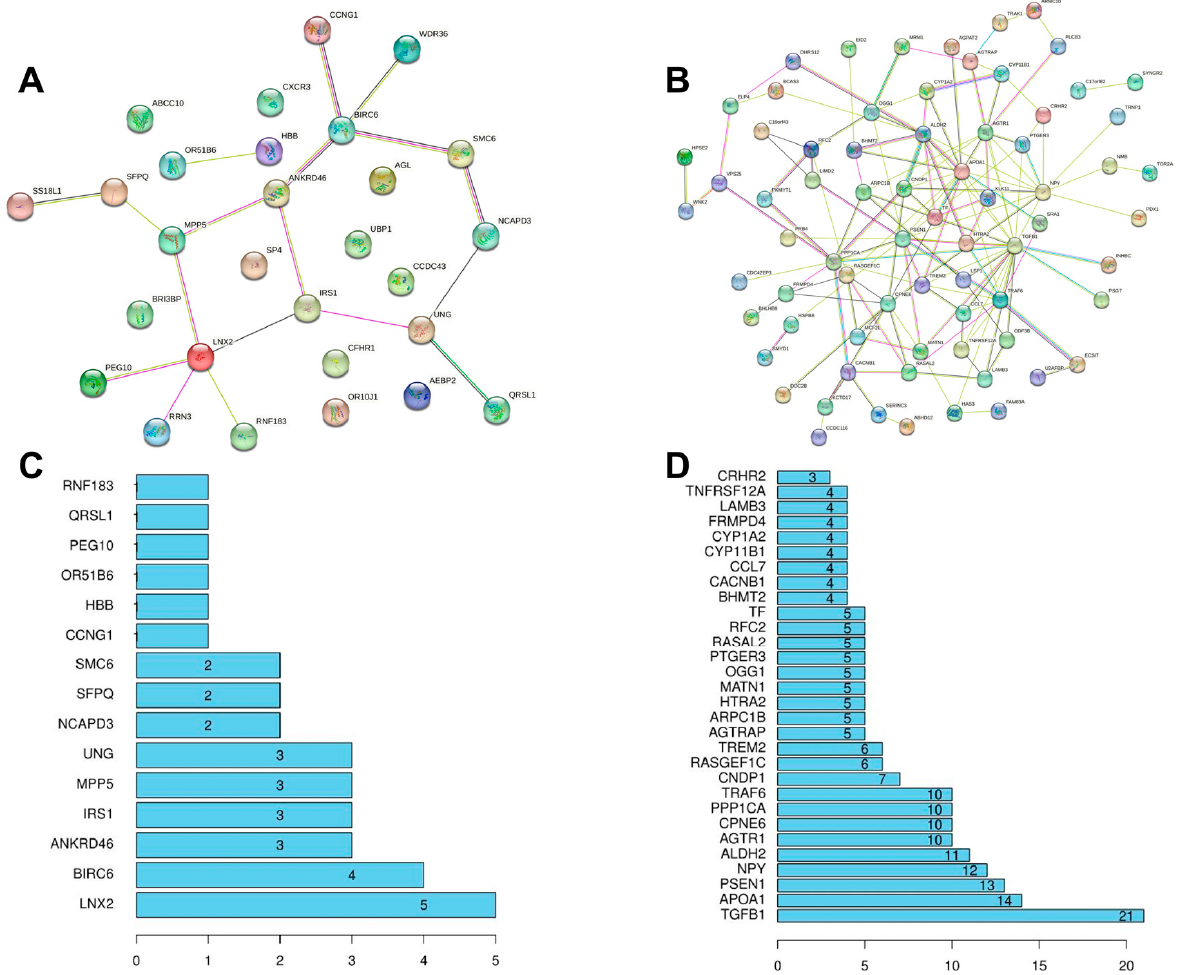
Figure 5. Protein–protein interaction (PPI) analysis of ( A ) upregulated co-DEGs; ( B ) downregulated co-DEGs; ( C ) hub genes in downregulated co-DEGs; ( D ) hub genes in upregulated co-DEGs. Table 3. Diagnostic value of hub genes in MCI and T2DM.